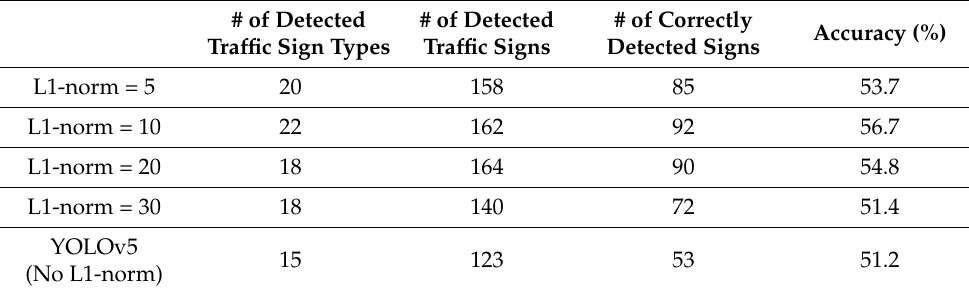
Table 1. L1-norm selection for YOLOv5.